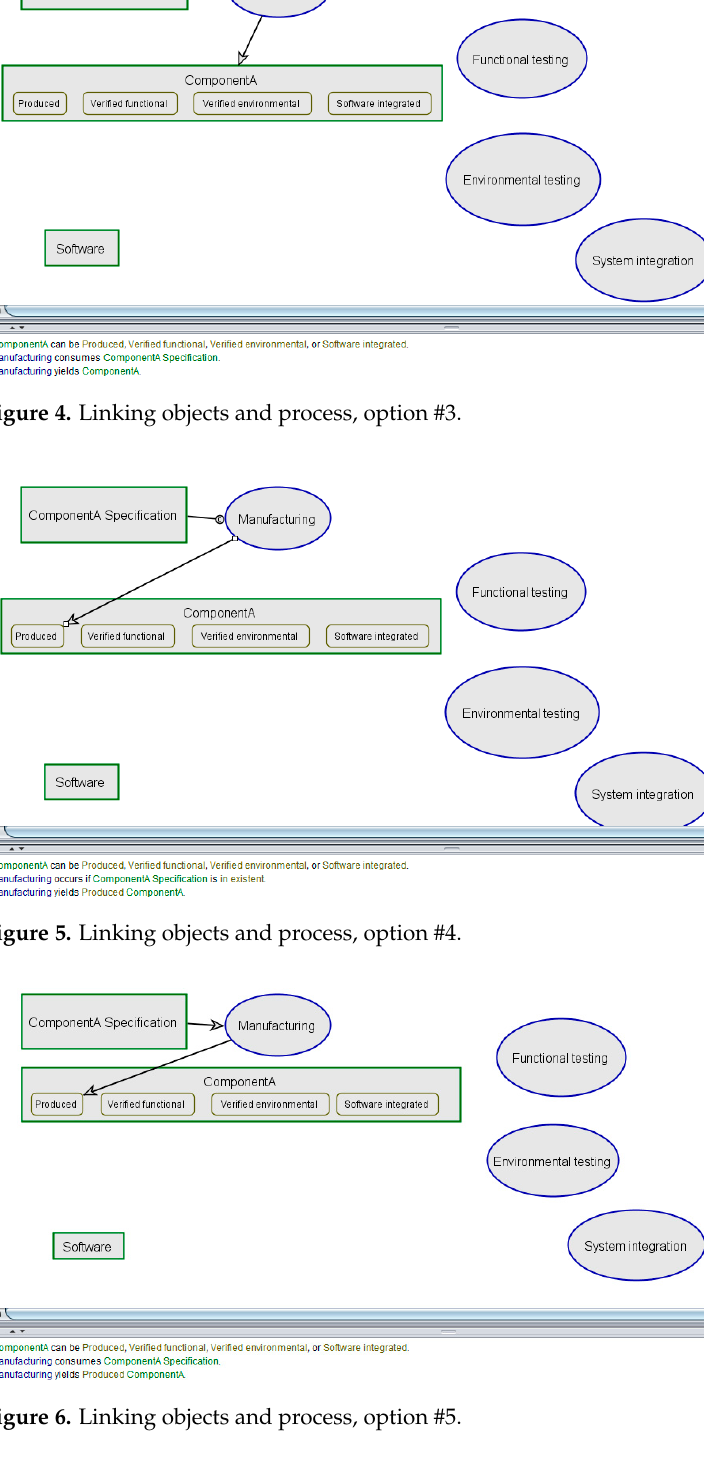
Figure 3. Linking objects and process, option #2.